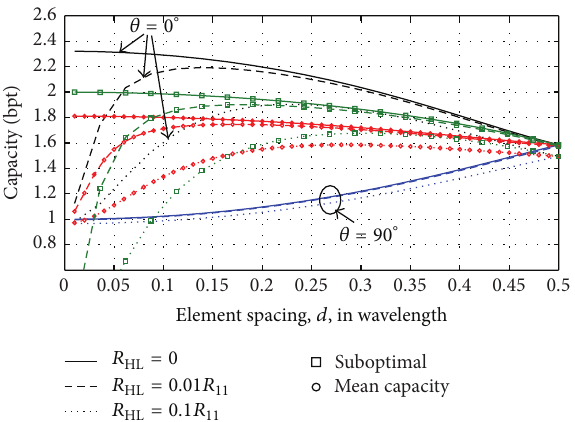
Figure 4: Instantaneous and mean capacity versus antenna spacing for a two-element receive MEA with heat losses for an equivalent SISO SNR of zero